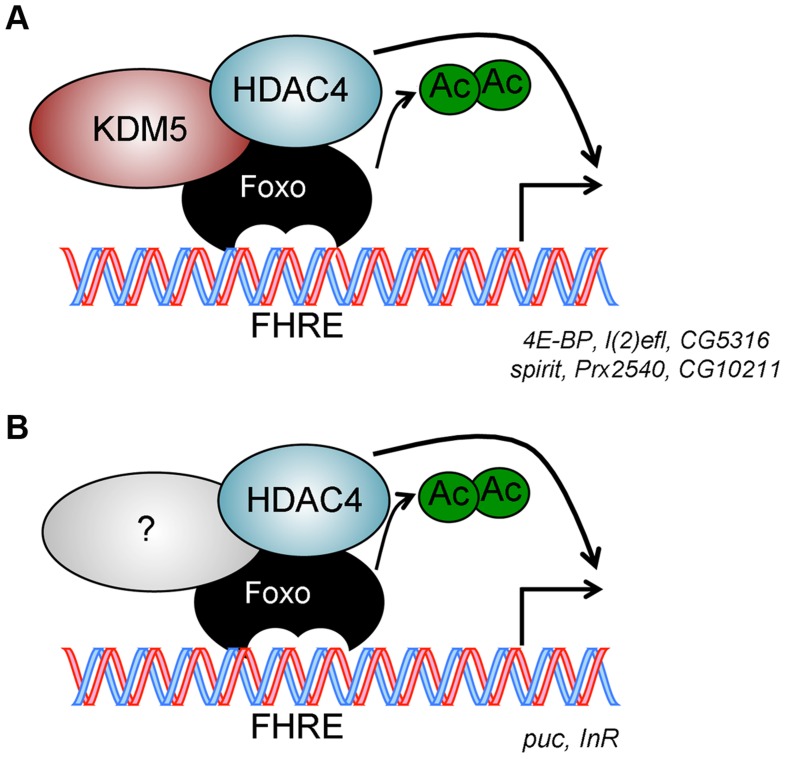
Model for KDM5 function.(A) KDM5-Foxo co-regulated genes are a subset of all Foxo regulated genes. We propose that at these stress response-related promoters, KDM5 facilitates the deacetylation of Foxo (and activation of its DNA binding activity) by binding to HDAC4. (B) Because HDAC4 is required at additional Foxo-regulated genes that are not affected by loss of KDM5, we propose that HDAC4-Foxo complexes that lack KDM5 regulate different targets than KDM5-HDAC4-Foxo complexes (e.g. InR and puc). Additional, as yet uncharacterized, proteins (shown as unlabeled shapes in A and B) are likely to be present in both KDM5-HDAC4-Foxo and HDAC4-Foxo complexes. See text for details.